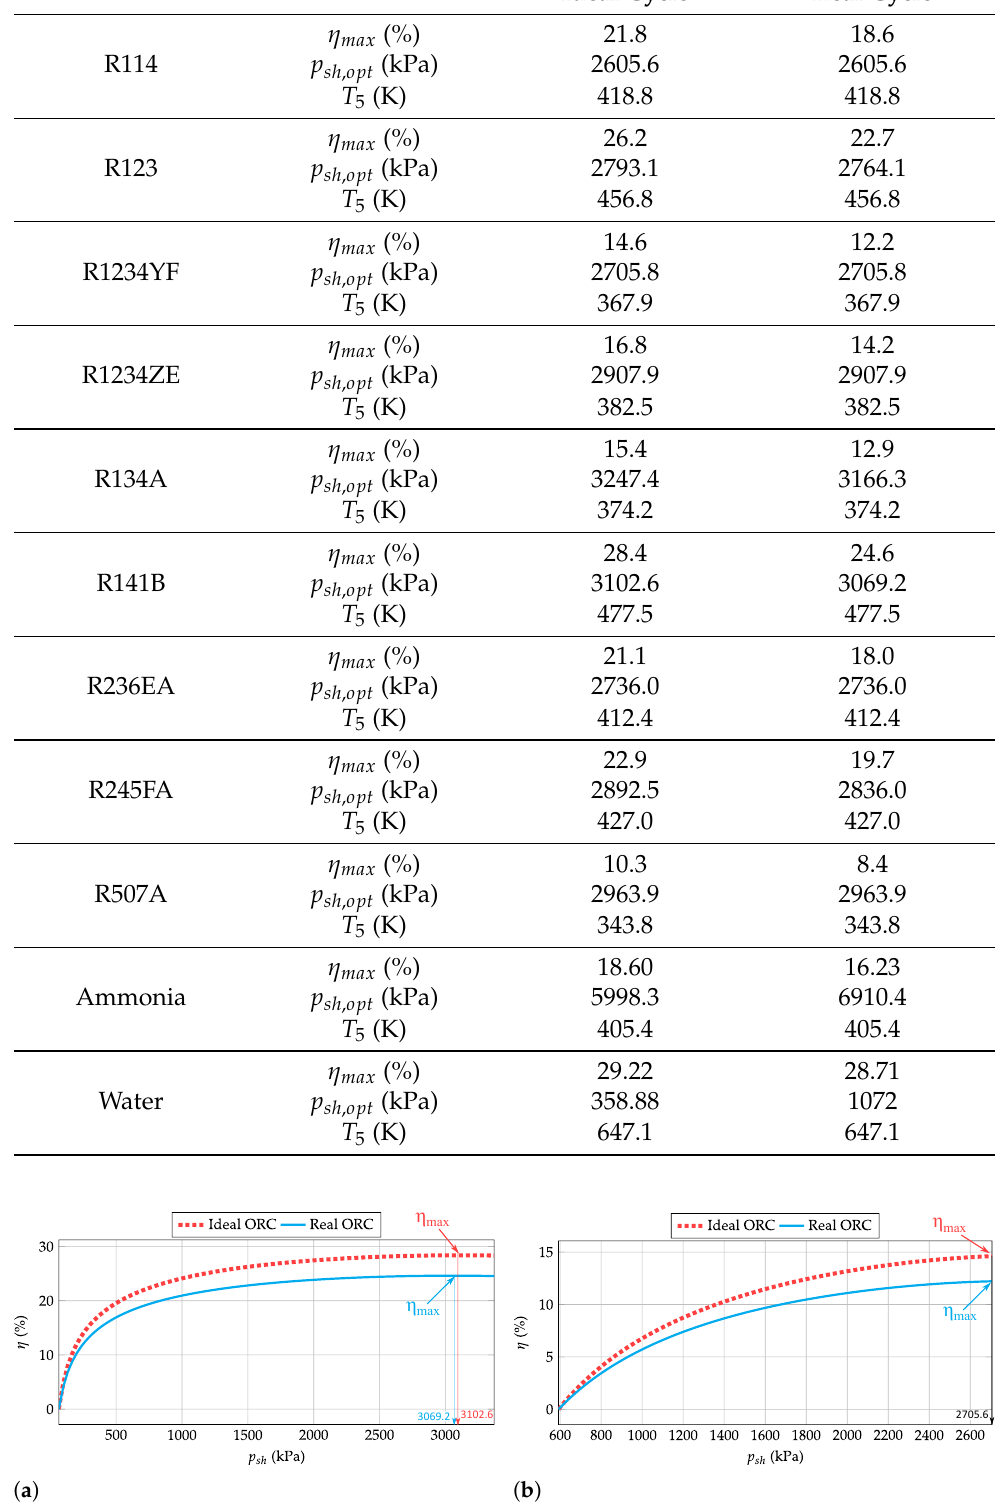
Figure 3. Example of performance evolution for two working fluids considering ideal and real ORC. ( a ) R141B; ( b )